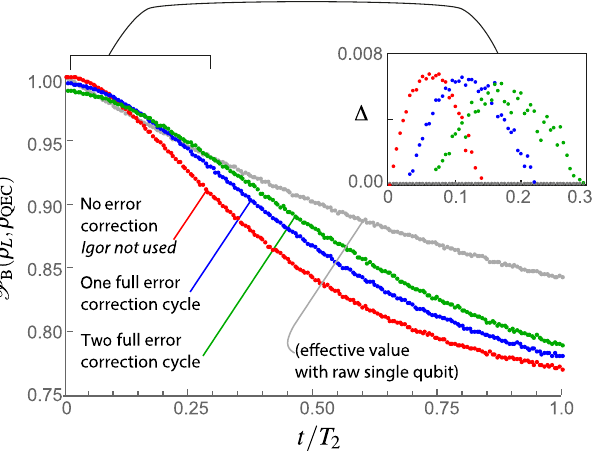
FIG. 27. Success probability P under the hiding-based, two- B FIG. 26. Success probability P under repetitive, two-species, B species QEC cycle with multiqubit MS gates (cf. Fig. 20): The shuttling-based QEC cycles with multiqubit MS gates (cf. Fig. 18): parameters underlying the simulation correspond to the future improved values from Tables II – V. Experimental capabilities (two-species, cooling, etc.) are the same as in Fig. 23, and we use the more challenging (worst-case) noise model (iii) of multiqubit depolarizing noise [Eq. (16)]. Results show that there exists a quantum channels [Eq. (15)]. For a single QEC cycle, direct clear parameter window for which the application of an imperfect comparison to the results of Fig. 25 shows no appreciable Igor QEC cycle becomes advantageous both as compared to not difference. Hence, we can conclude that using the more- applying it [Eq. (2)] and compared to an unprotected single pessimistic noise model with a multiqubit depolarizing channel physical qubit [Eq. (3)]. Note that the P value where the QEC B [Eq. (16)] or using the one with equally likely one- and two-qubit cycle crossover towards a beneficial Igor takes place is around errors [Eq. (15)] does not make any difference. We also depict the 0.982, which is very similar to the behavior found for the results for two rounds of QEC (green dots), where one sees an shuttling-based protocol 2 with future parameters (cf. Fig. increase of the region [Eq. (3)] where QEC is advantageous compared to a single nonencoded physical qubit with respect to the case with a single QEC round. The inset plots Δ , which is P B relative to that for the single-qubit memory. We see that multiple rounds of QEC allow us to sustain the logical qubit for a longer period of time. In the inset, we display the relative performance Δ of the encoded (red), single-cycle QEC (blue), and two-cycle QEC (green) with respect to the unprotected physical qubit, which is obtained by subtracting the bare qubit P of the main B panel (grey line), from P for the different schemes, also in the B main panel. As emphasized before, we observe a wider region of advantage for the two cycles of QEC.